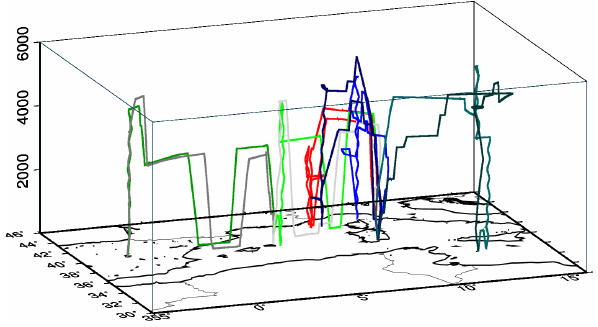
Figure 4. ATR-42 vertical trajectories for the flights of 14 (red), 16 and 17 (blue), 19 and 20 (green) and 22 June (green-blue). Table 2. List of ATR flights for the tropospheric measurements of meteorological variables and ozone concentrations. N data cor- responds to the number of data after averaging the high temporal frequency of aircraft measurements to a constant 5mn time step. Flight